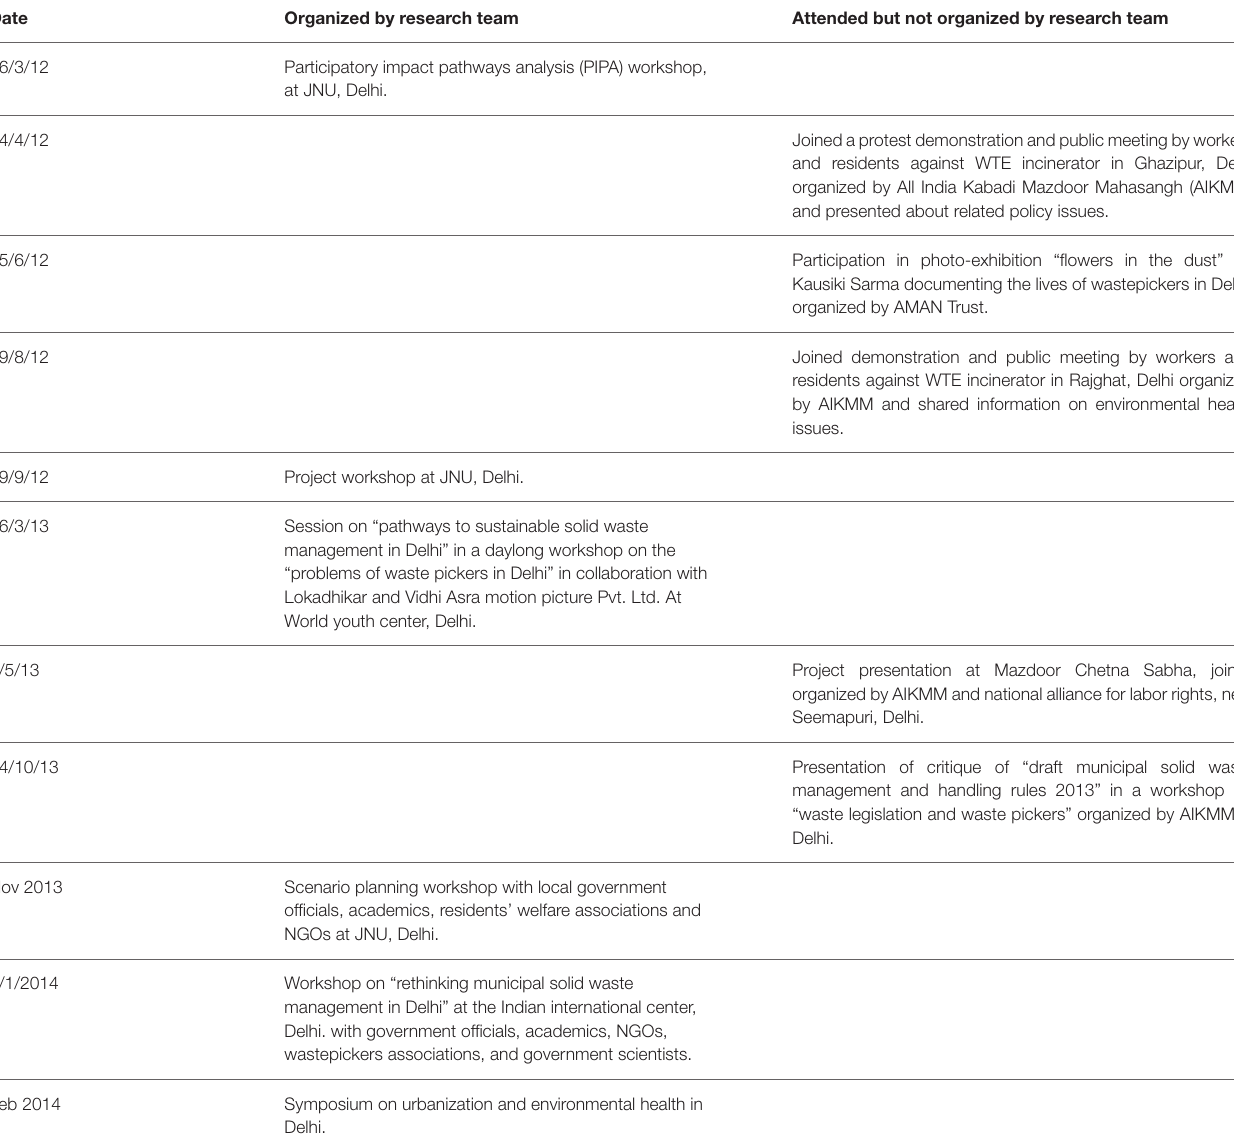
TABLE 1 | Key Outreach and Policy Engagement Activities.